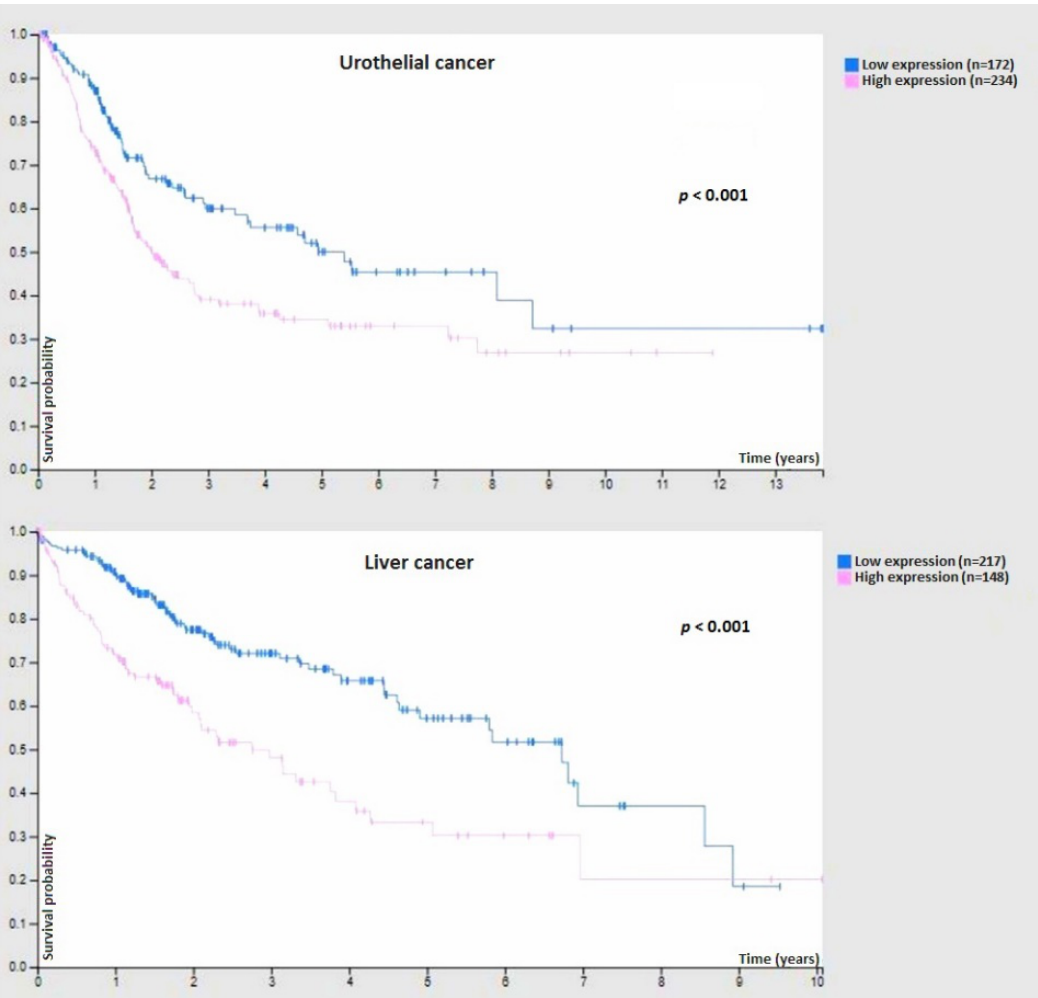
Figure 3. Prognostic relevance of GANAB expression in urothelial cancer ( top ) and liver cancer ( bottom ). In both cases, a high expression of this molecule is a marker of an unfavorable clinical outcome. (Figure reproduced from https://www.proteinatlas.org/ENSG00000089597-GANAB/ pathology, accessed on 5 March